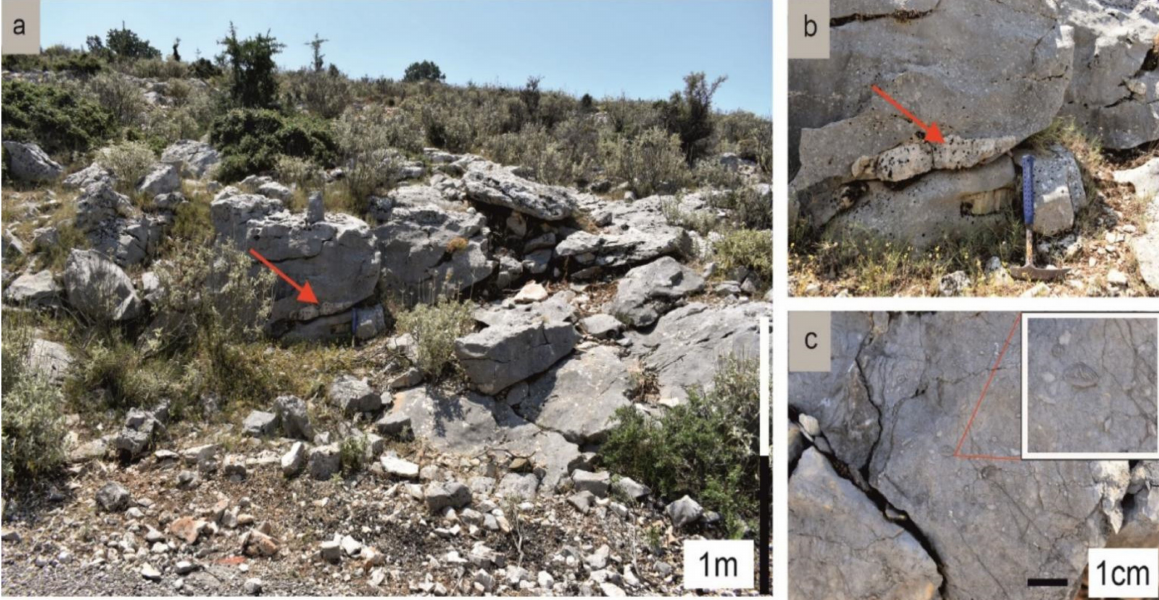
Figure 14. ( a ) General view of the outcrop of the Eocene “Platy Limestones”, ( b ) Eocene “Platy Limestones, ( c ) Thick-bedded, micro-brecciated limestones with Nummulites .